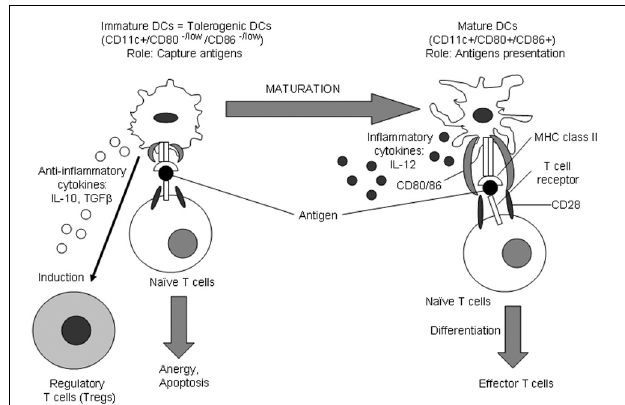
FIGURE 1 | Immature and mature DCs. Immature DCs arise from DC precursors that circulate in the blood. From the blood, DC precursors may reach the target tissue where they transform into immature DCs. The major function of immature DCs is the capture of antigens. Immature DCs capturing antigens may then migrate into lymphoid tissues such as the spleen and lymph nodes where they further differentiate becoming mature DCs. Mature DCs are capable to efficiently present captured antigens to naïve T cells. DC maturation is characterized by the up-regulation of expression of molecules responsible for antigen presentation such as MHC class II and CD80/CD86. After antigen recognition, naïve T cells differentiate into effector T cells. Differentiation of naïve T cells to effector cells may occur upon cell-cell contacts between a DC and a naïve T cell and via proinflammatory cytokine IL-12 secreted by mature DCs. Immature DCs lacking sufficient expression of antigen-presenting molecules cause anergy and apoptosis of naïve T cells. Immature DCs possess tolerogenic properties by inducing Tregs through cell-to-cell contact with naïve T cells and through secreting anti-inflammatory cytokines such as IL-10 and TGF- β . Since immature DCs are capable to induce Tregs and inhibit the inflammatory reaction in the atherosclerotic plaque, the development of strategies for the induction of tolerogenic DCs is of great therapeutic